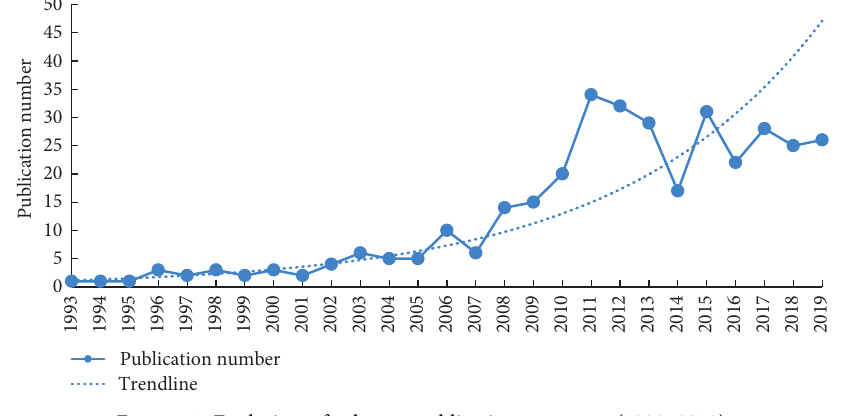
Figure 1: Evolution of relevant publications per year (1993–2019).